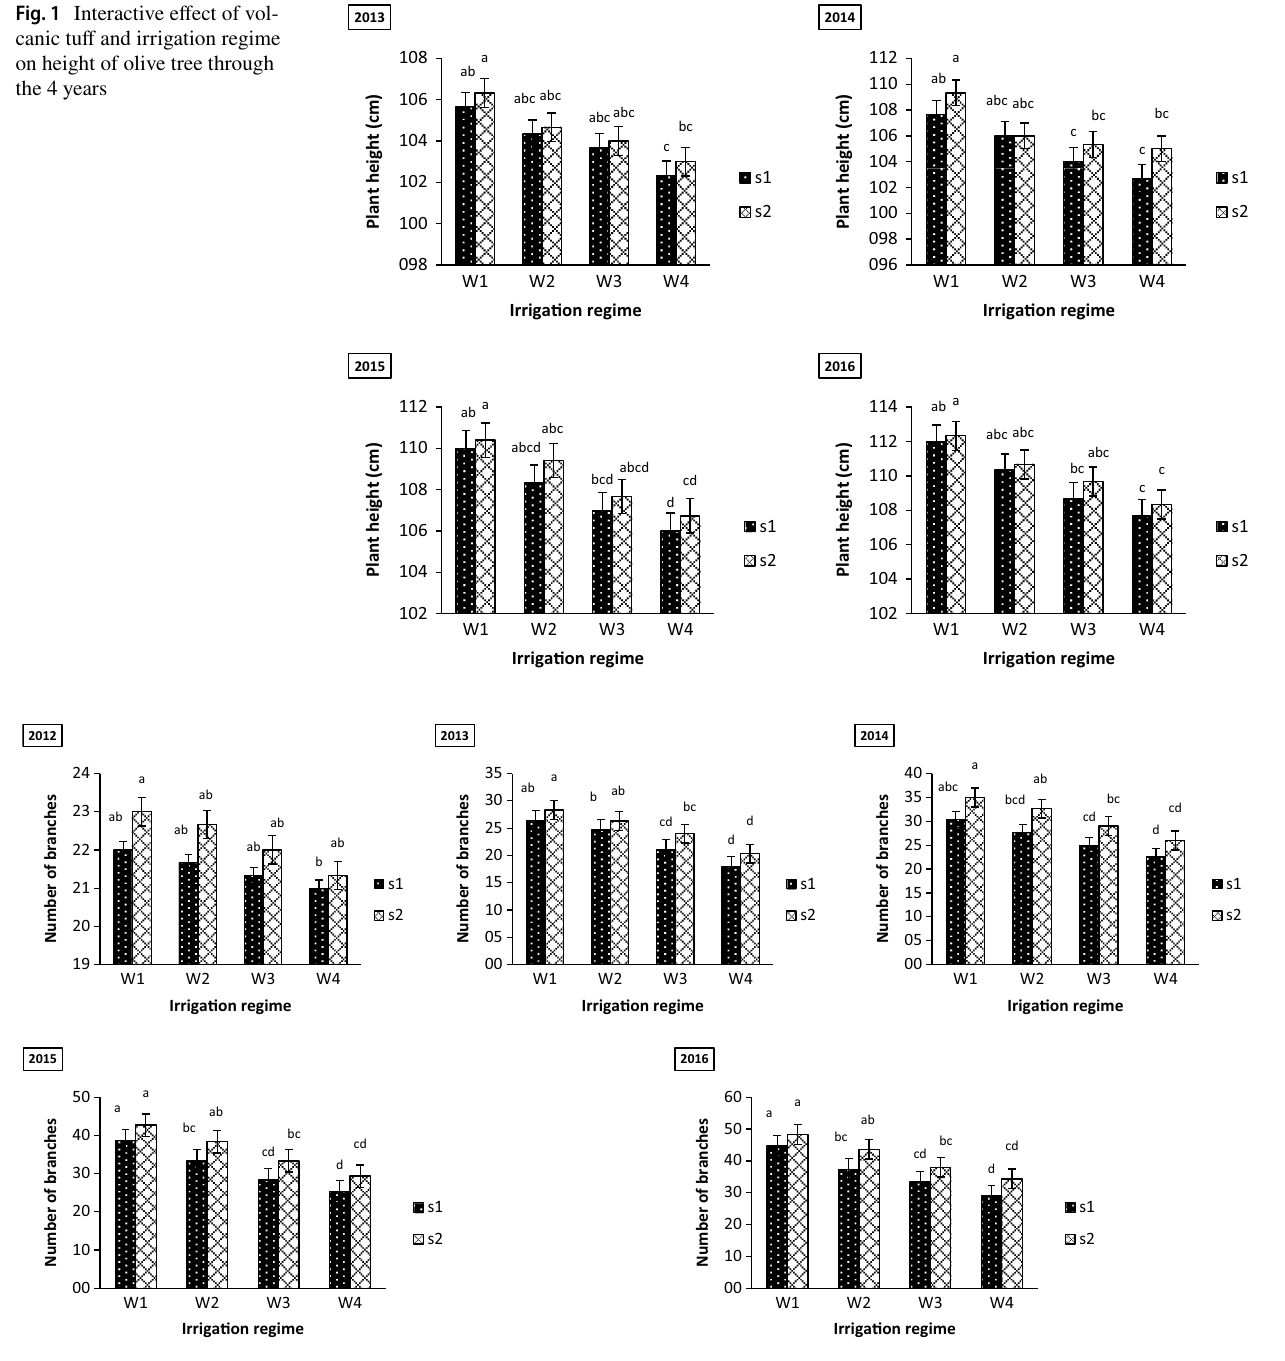
Fig. 2 Interactive effect of volcanic tuff and irrigation regime on number of branches of olive tree through the 5